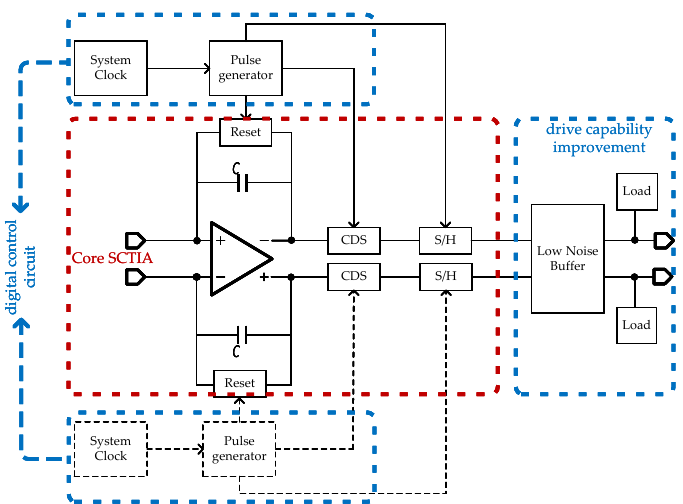
Figure 2. The schematic of the weak current detection system.